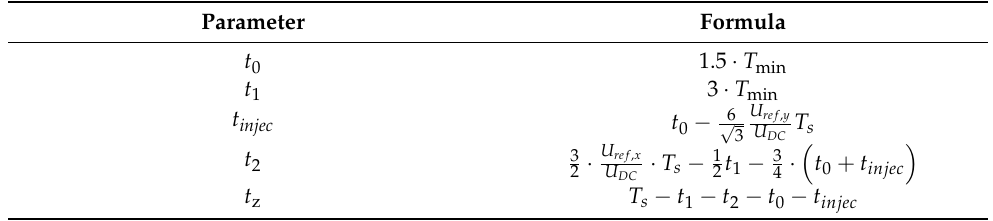
Table 7. Time calculation for the proposed SVM pattern for Region 3 applied inside the inner hexagon. Parameter